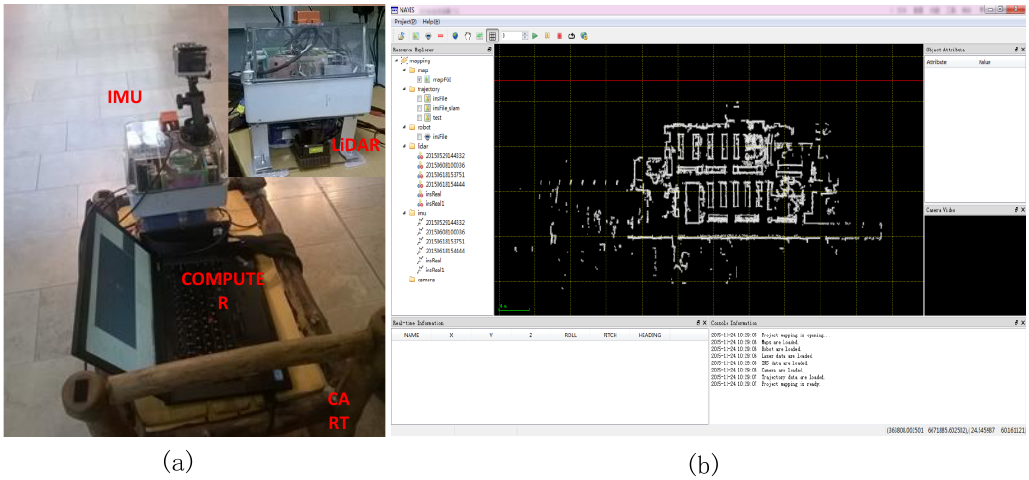
Figure 3. ( a ) NAVIS indoor mapping hardware platform; ( b ) corresponding point cloud from the test site.